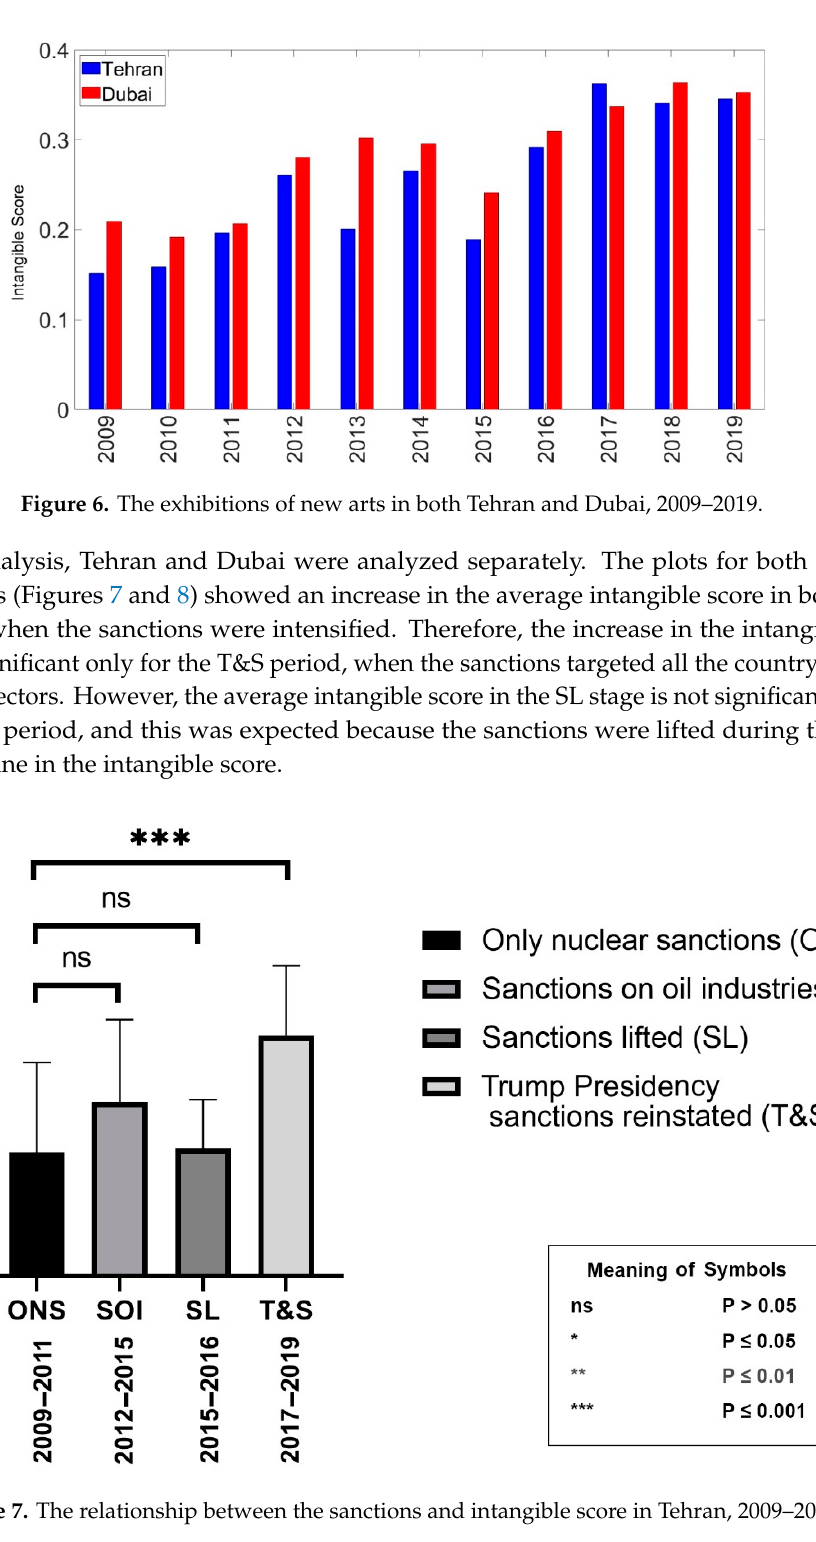
Figure 8. The relationship between the sanctions and intangible score in Dubai, 2009–2019.